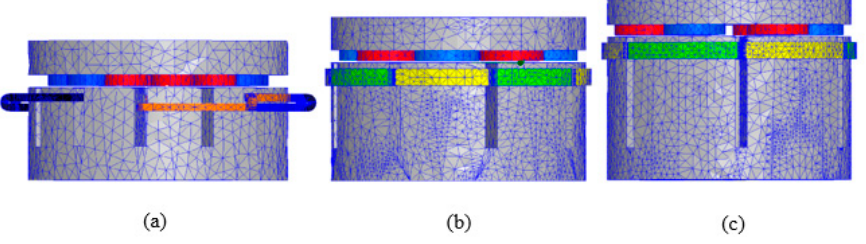
Figure 6. 3-D representation of mesh decomposition for M 1 ( a ); M 2 ( b ) and M 3 ( c )